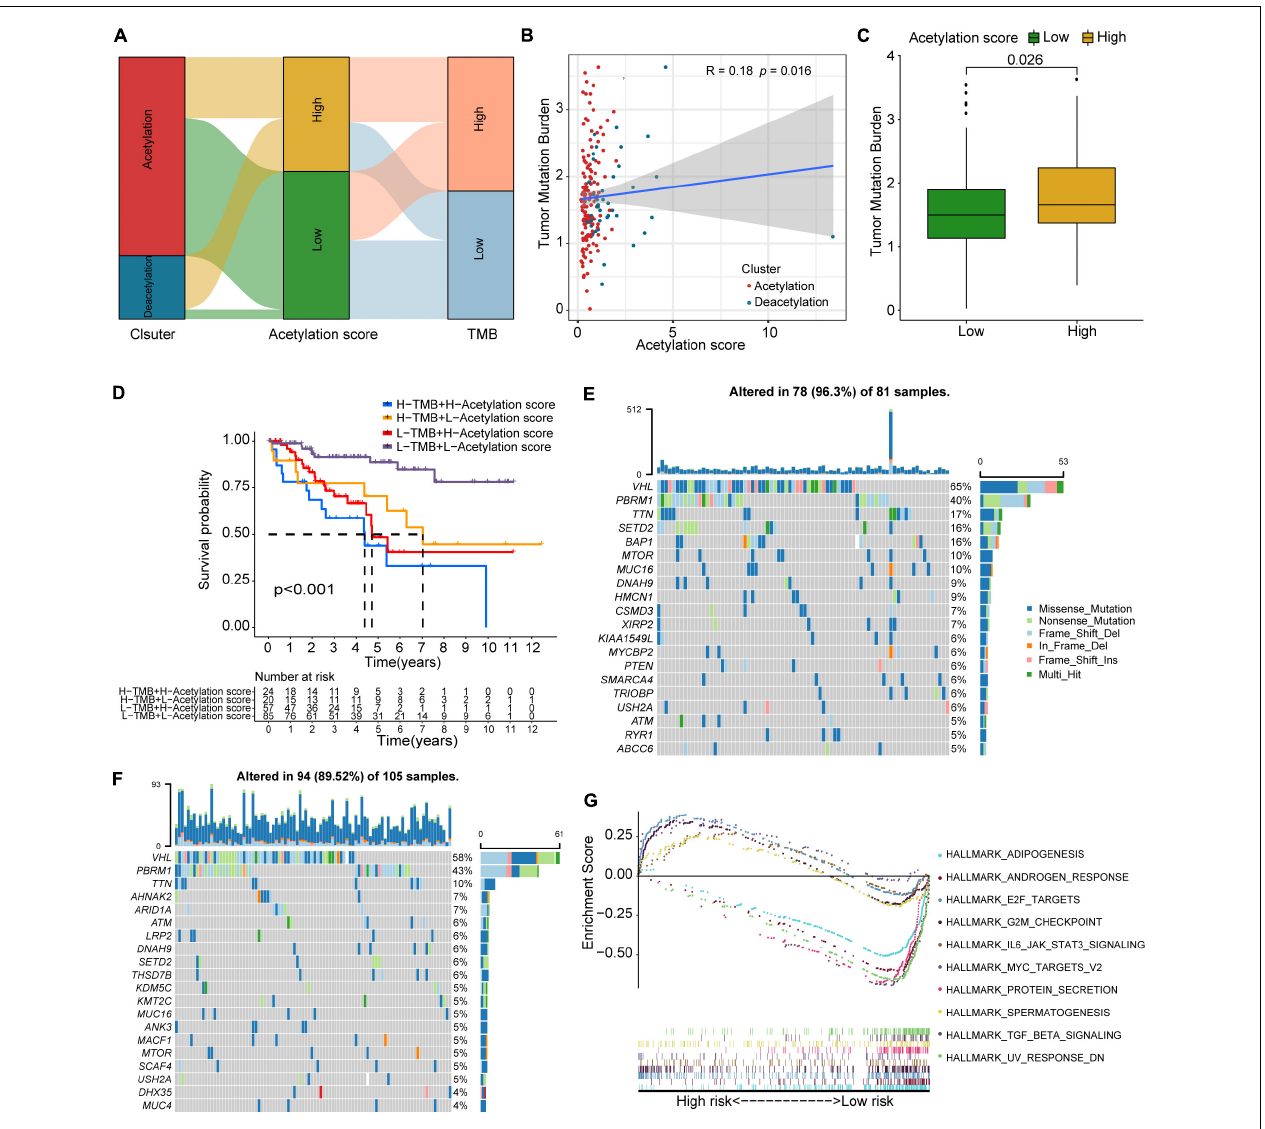
FIGURE 6 | TMB correlation, mutation landscape, and GSEA. (A) Sankey plot including subtypes, acetylation-related score, and TMB. (B) Correlation analysis between TMB and acetylation-related score. (C) Comparison of TMB between high and low acetylation-related score groups. (D) Survival analysis for the combination of TMB and acetylation-related score. (E,F) The waterfall plots of somatic mutation for high-risk and low-risk groups respectively. (G) The results of